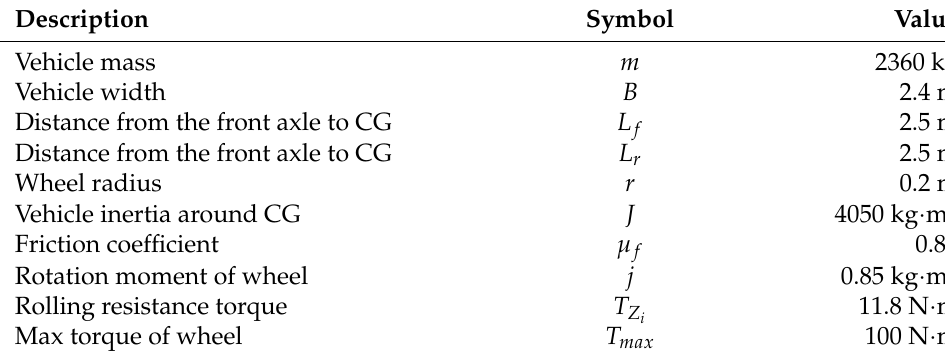
Table 1. Vehicle dynamics